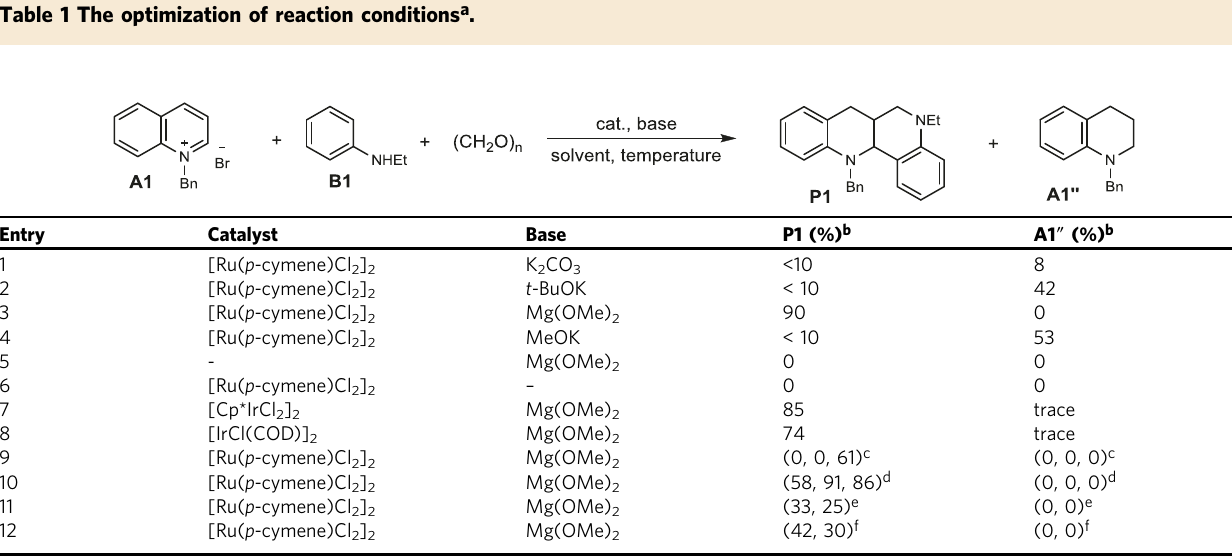
Table 1 The optimization of reaction conditions a